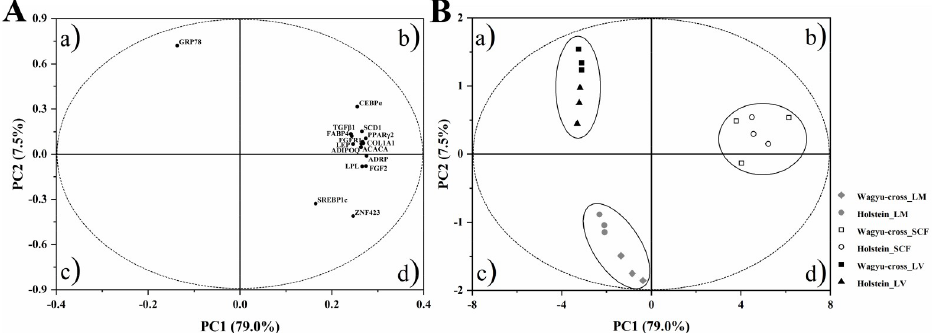
Fig 5. Loading plot (A) and score plot (B) of the principal component analysis (PCA) for gene expression in the LM, SCF and liver. LM: longissimus muscle, SCF: subcutaneous fat, LV: